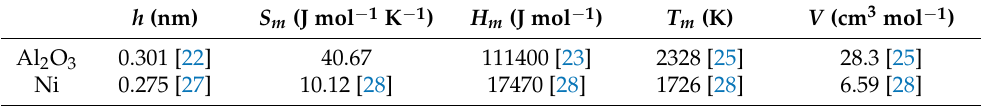
Table 1. The related parameters used in calculating interface free